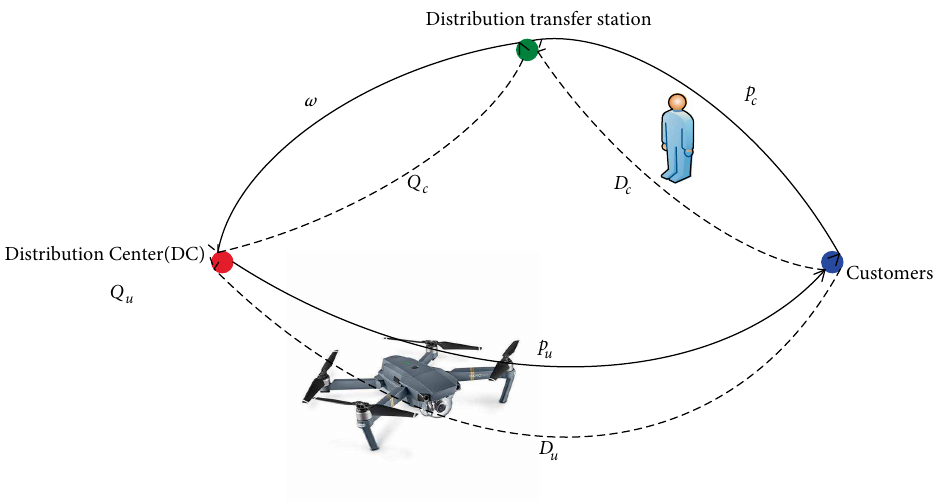
Figure 1: The last-kilometer dual-channel structure under the uncertainty of